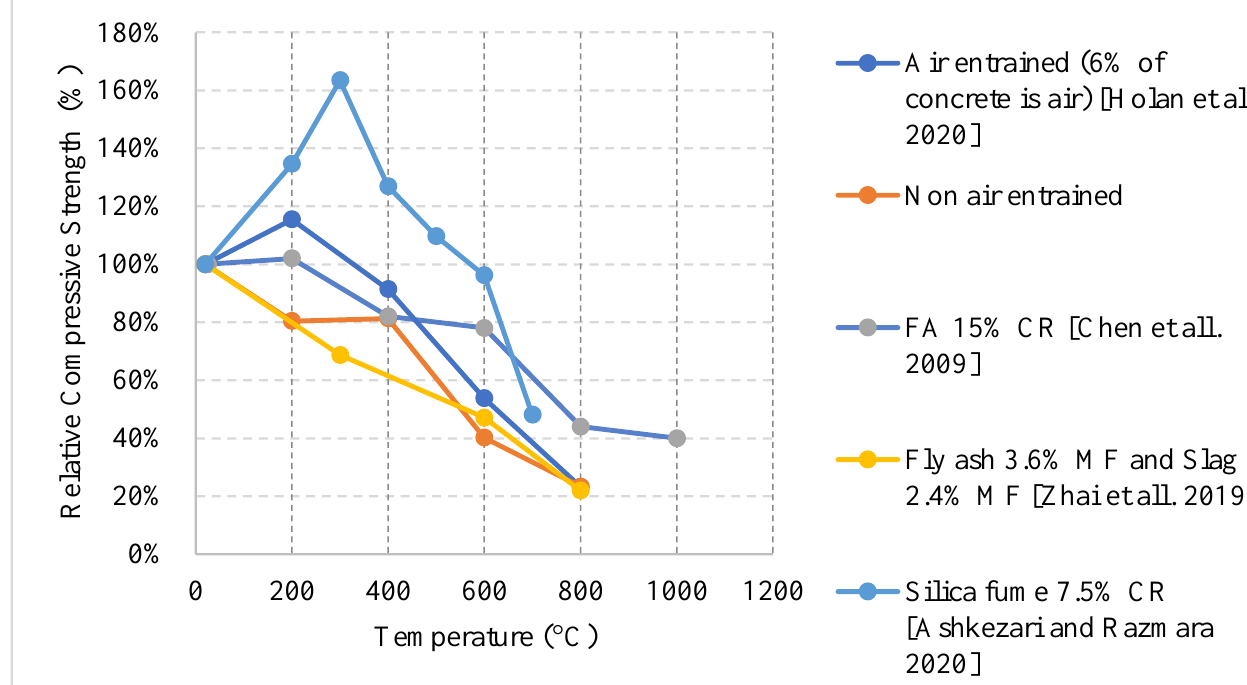
Figure 4. Effect of different constituents on the relative compressive strength of naturally cooled NSC. CR: Cement Replacement, MF: Mass Fraction [35–38].